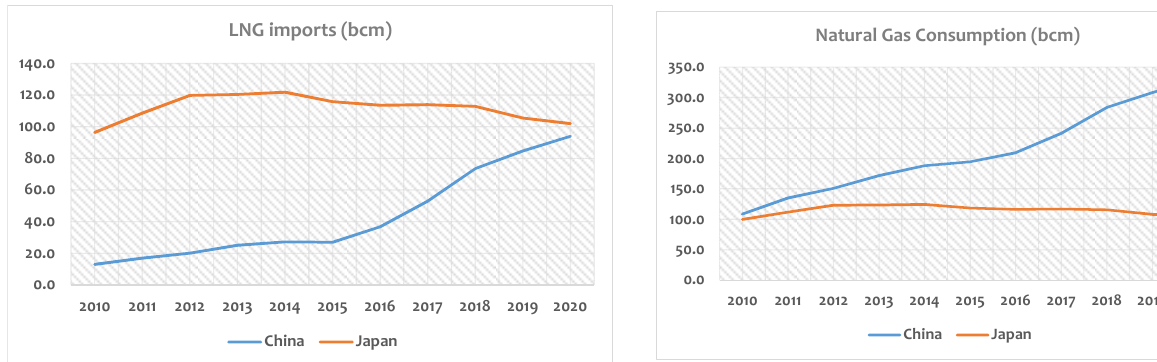
Figure 6. Based on data from [4].